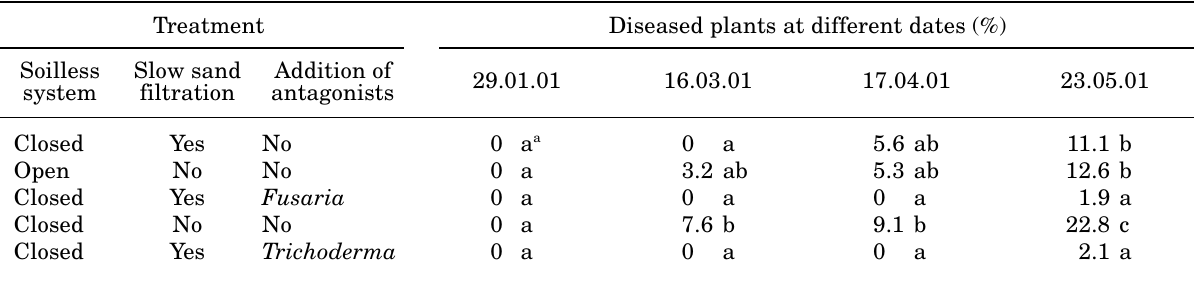
Table 6. The effect of selected strains of Fusarium and Trichoderma on P. cryptogea root rot of gerbera grown in different closed soilless systems (Albenga, 2001).